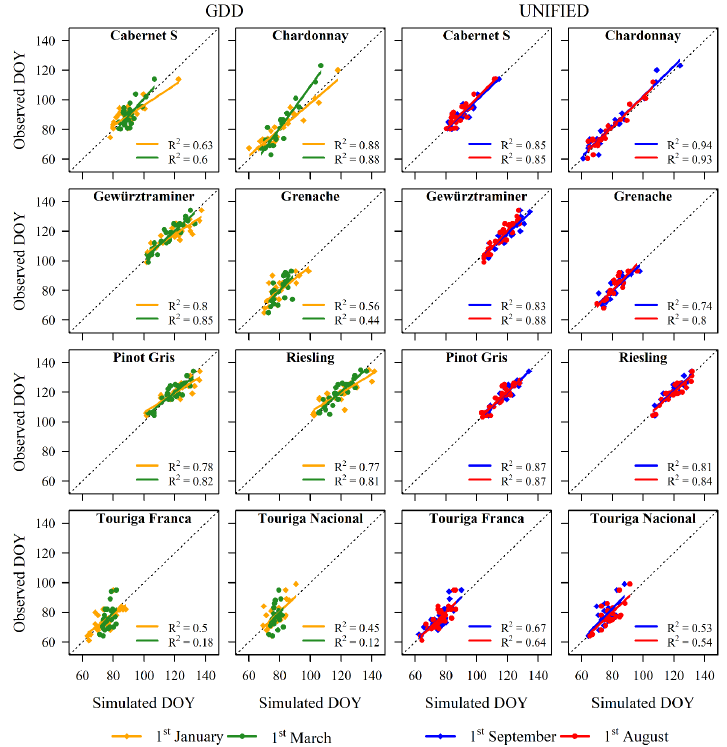
Figure 4. Correlations between observed and simulated budbreak Days of Year (DOY) of the GDD and UNIFIED models. The results were obtained for all grapevine varieties and starting dates using the HP parameter set.